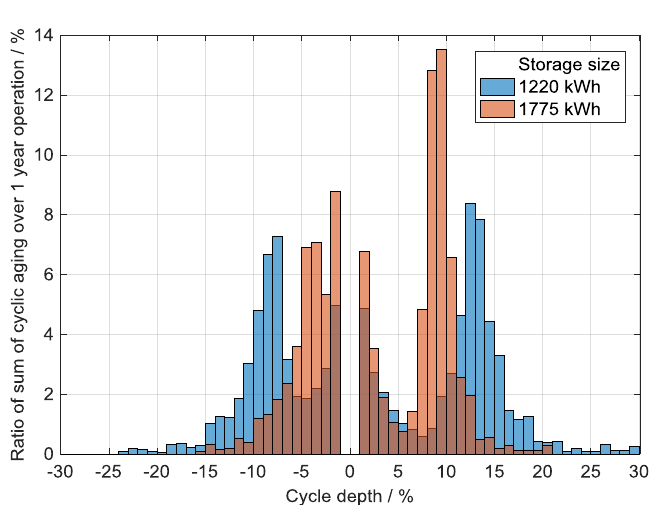
Figure 15. Relative frequency of cycle depth.